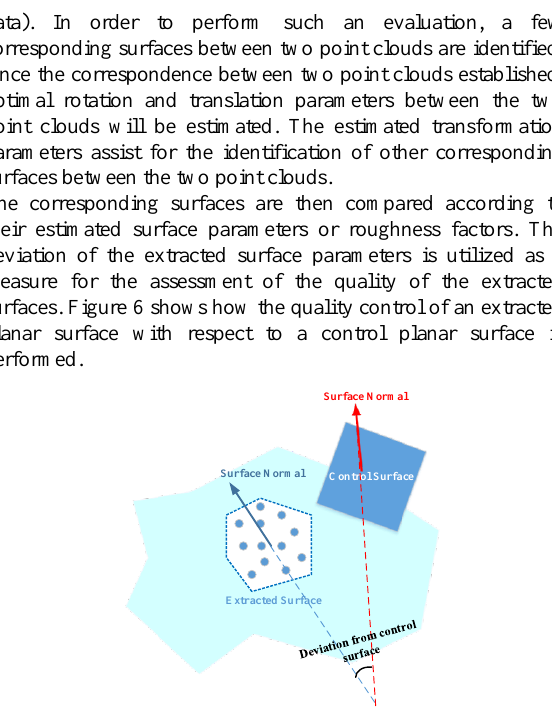
Figure 6. Quality control of an extracted planar surface with respect to a control planar surface is